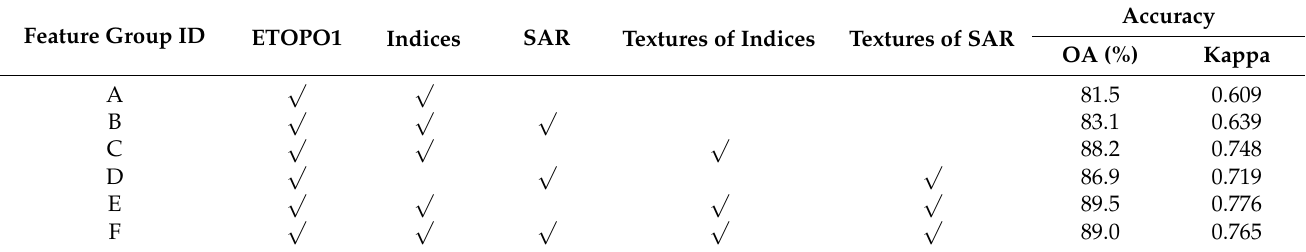
Table 3. Classification performances using different feature